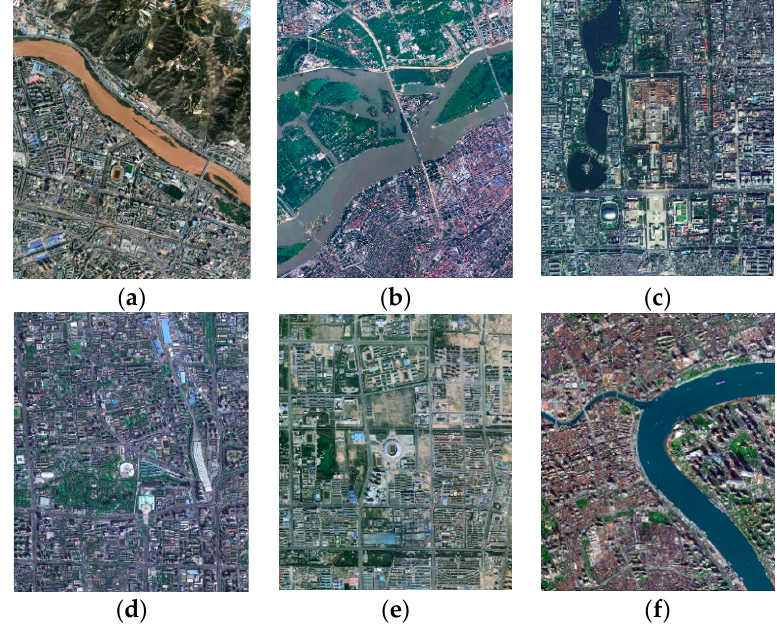
Figure 9. The testing HRRS images used in the experiment: ( a ) Image A (4200 × 5000 pixels), ( b ) image B (4200 × 5000 pixels), ( c ) image C (4200 × 5000 pixels), ( d ) image D (4200 × 5000 pixels), ( e ) image E (4200 × 5000 pixels), ( f ) image F (4200 × 5000 pixels).